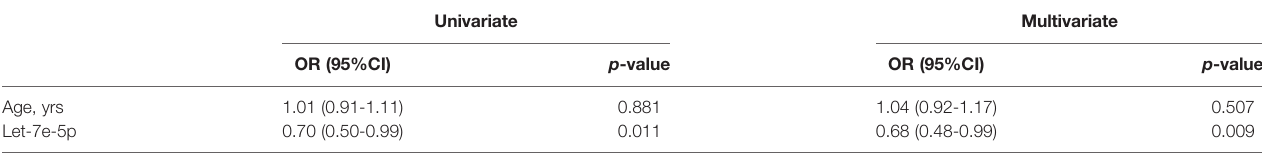
Multivariate analysis was adjusted for age. CI, con fi dential interval; OR, odds